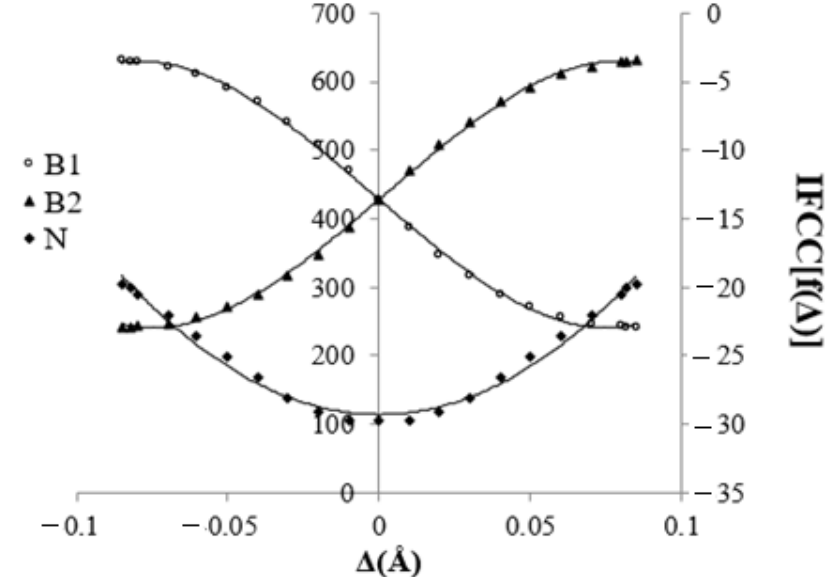
Figure 3. Isotropic Fermi contact coupling (IFCC) of B 2 N (0).